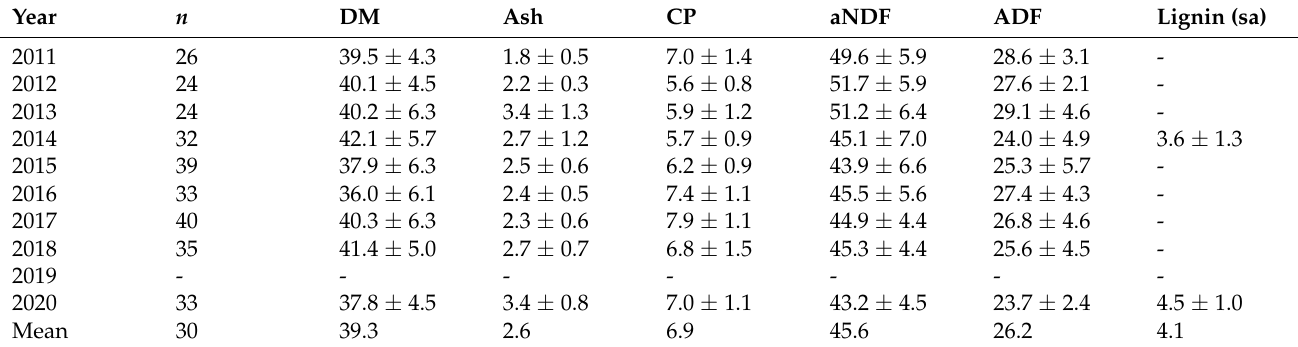
Table 8. Nutritional value of corn silages (mean ± SD) sampled in the state of Paran á , Brazil in ten summer crops (2011–2020).